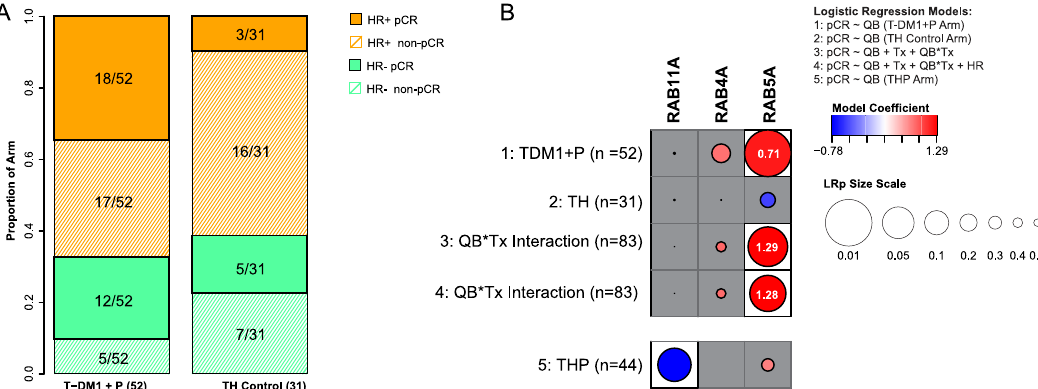
Fig. 4 T-DM1 and RAB GTPase correlations in the I-SPY2 cohort. A Number of patients, hormone receptor (HR) status, and pathological complete responses (pCR) in the T-DM1 + pertuzumab and trastuzumab-paclitaxel arm of the I-SPY2 study. B Association plot summarizing qualifying biomarker analyses of RAB4A, RAB5A, and RAB11A expression levels as speci fi c predictors of pCR to indicated treatment. Results are organized by the logistic model/ data used along the rows, and the biomarker evaluated along the columns. Circle sizes are proportional to the signi fi cance ( − log10 (LR test p )); and circle color re fl ects the magnitude of coef fi cient (red: positive, blue: negative) from each corresponding logistic model. White background indicates p < 0.05, and the odds ratio associated with 1 standard deviation increase in expression were also shown (in white) inside the circle. The 95% con fi dence intervals for the coef fi cients are found in Supplementary Table 1. Source data are provided as a Source Data fi